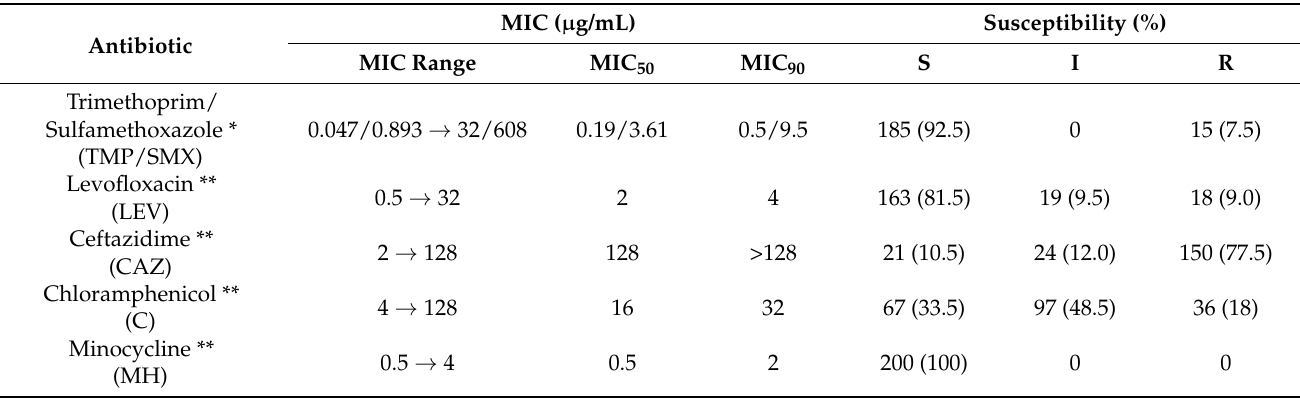
Table 2. Antibiotic susceptibility of S. maltophilia